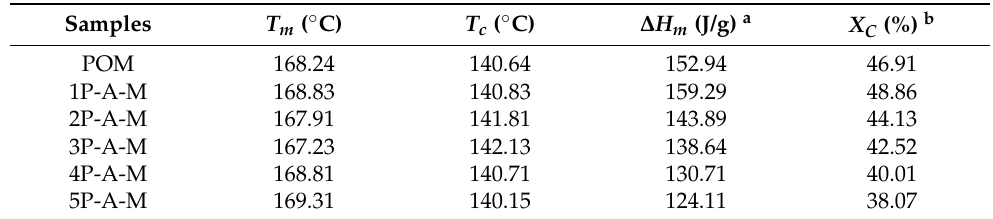
Figure 5. ( a ) Crystallization exotherms and ( b ) second melting end other ms of POM/Ag/MAH- g - POE ternary nanocomposites at a heating/cooling rate of 10 ◦ C/min. Table 2. Characteristic crystallization peak temperatures. Enthalpy and degree of crystallinity values of samples crystallized with a cooling rate of 10 ◦